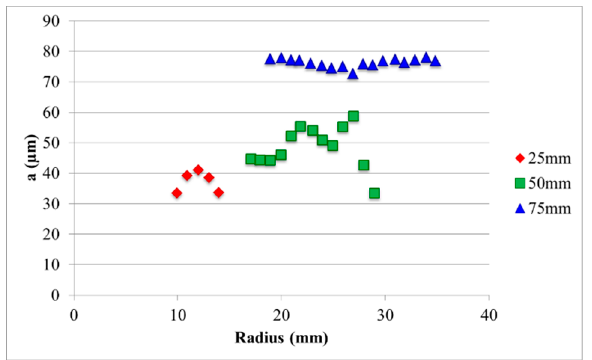
Figure 12. Droplet minimum diameter at axial distances of 25, 50, and 75 mm with non-swirling atomizing air.